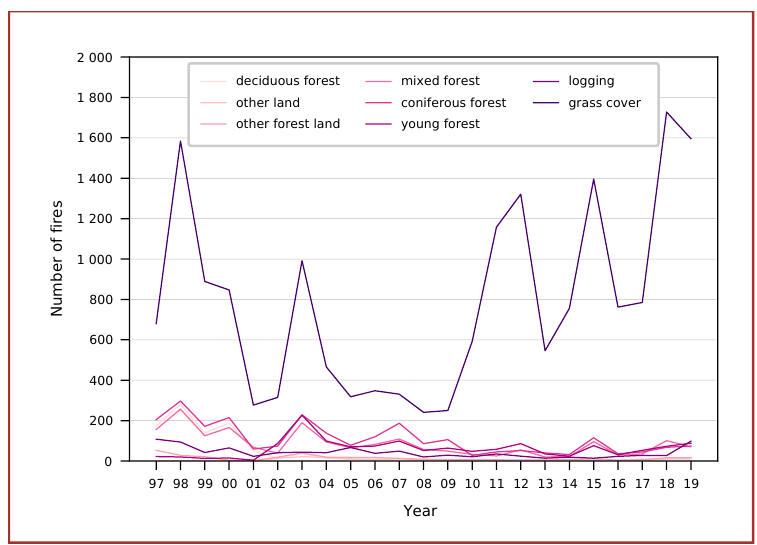
Figure 10. Various kinds of forest fires in the Czech